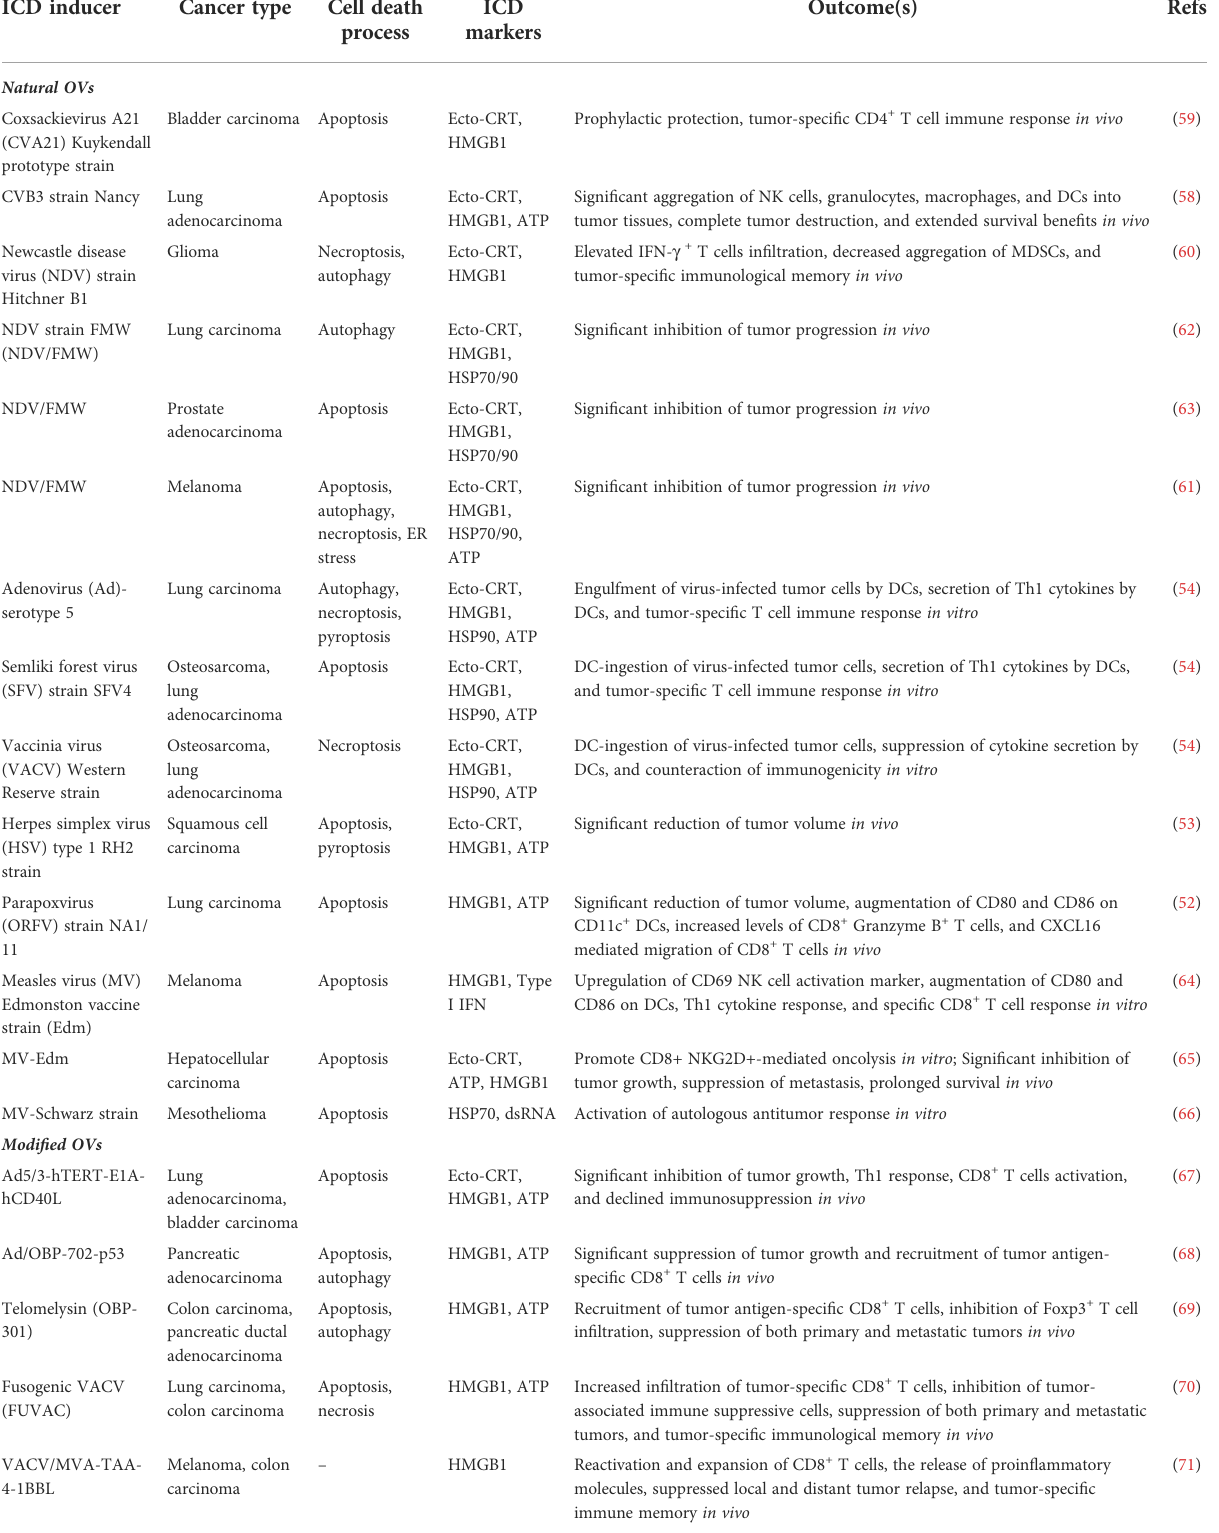
TABLE 1 ICD hallmarks induced by